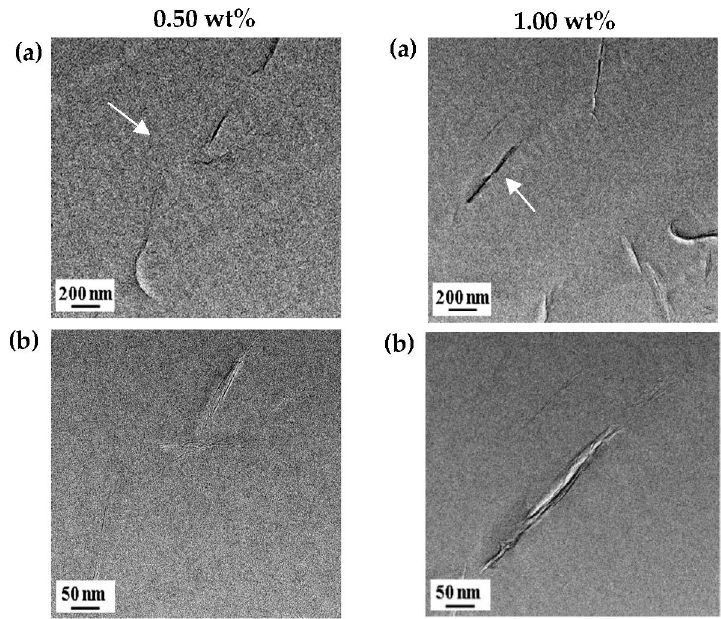
Figure 5. TEM micrographs of BAS hybrid films containing 0.5 wt% and 1.00 wt%. Cloisite 30 B with increasing magnification levels from ( a ) to ( b ).